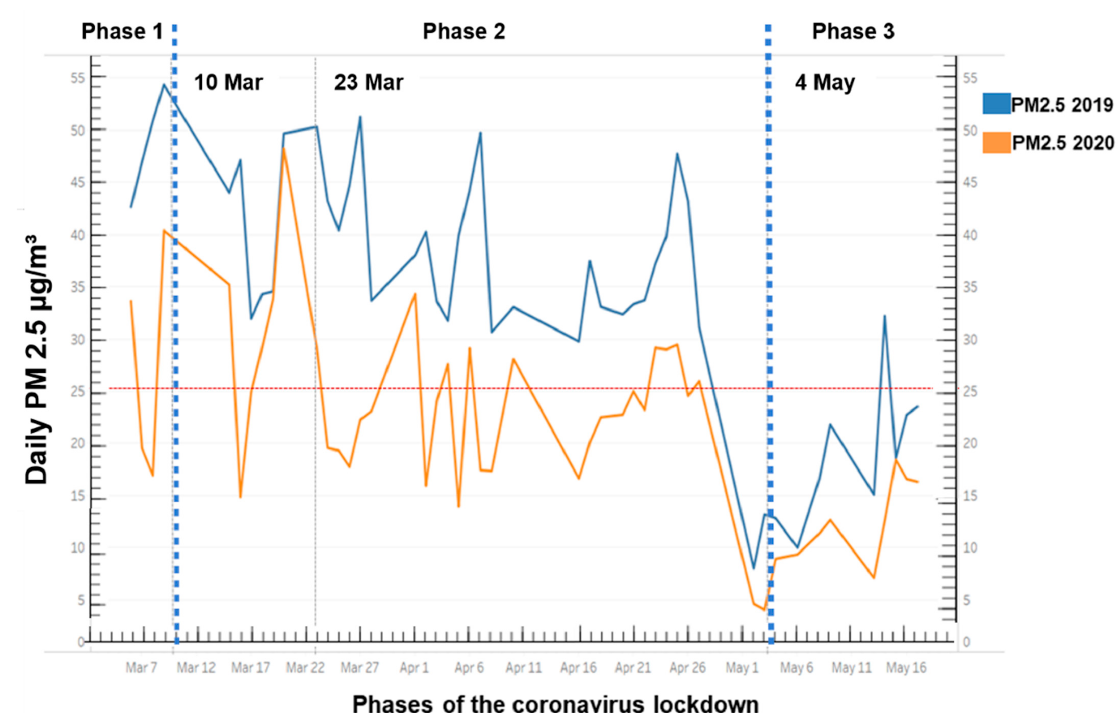
Figure 5. The trend of PM 2.5 concentration in the city of Volos, Central Greece, from 7 March to 16 May 2020, compared to PM 2.5 concentrations during the same period in 2019. The horizontal red dashed line identifies the PM 2.5 concentration at 25 µ g/m 3 set as a safe limit by the World Health Organization air quality guidelines. The dotted dash vertical lines indicate the start of each phase of the three-step approach to combat the COVID-19 wave. Phase 1 (pre-lockdown period): 7 March – 9 March, Phase 2 (lockdown period): 10 March – 4 May, and Phase 3 (post-lockdown period): 5 May – 16 May. The vertical black dashed line represents the initiation of the strictest period amid phase 2 (23 March 2020).